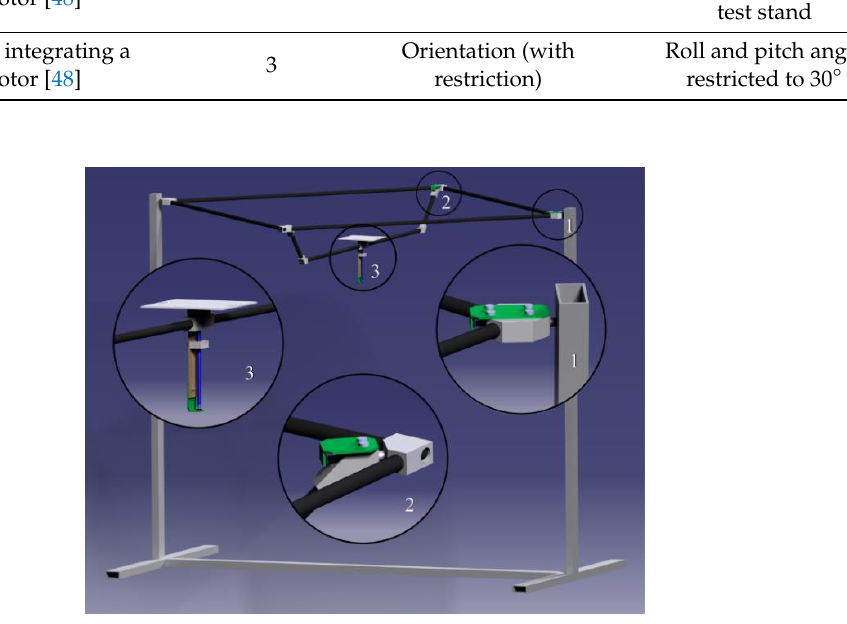
Figure 4. Design of test stand made in CAD software.